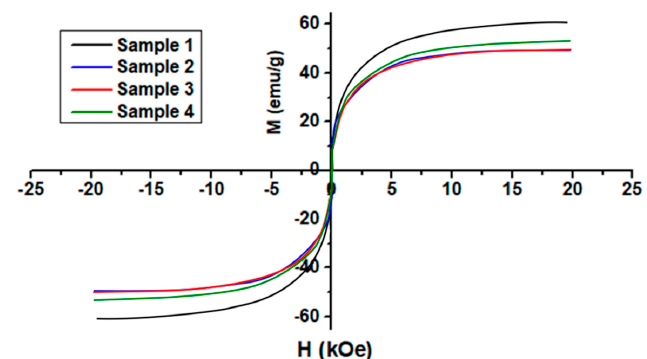
Figure 4. Magnetization curves of CoFe 2 O 4 nanoparticles (Sample 1) and aminodextran coated nanoparticles (Sample 2, 3 and 4) at room temperature.